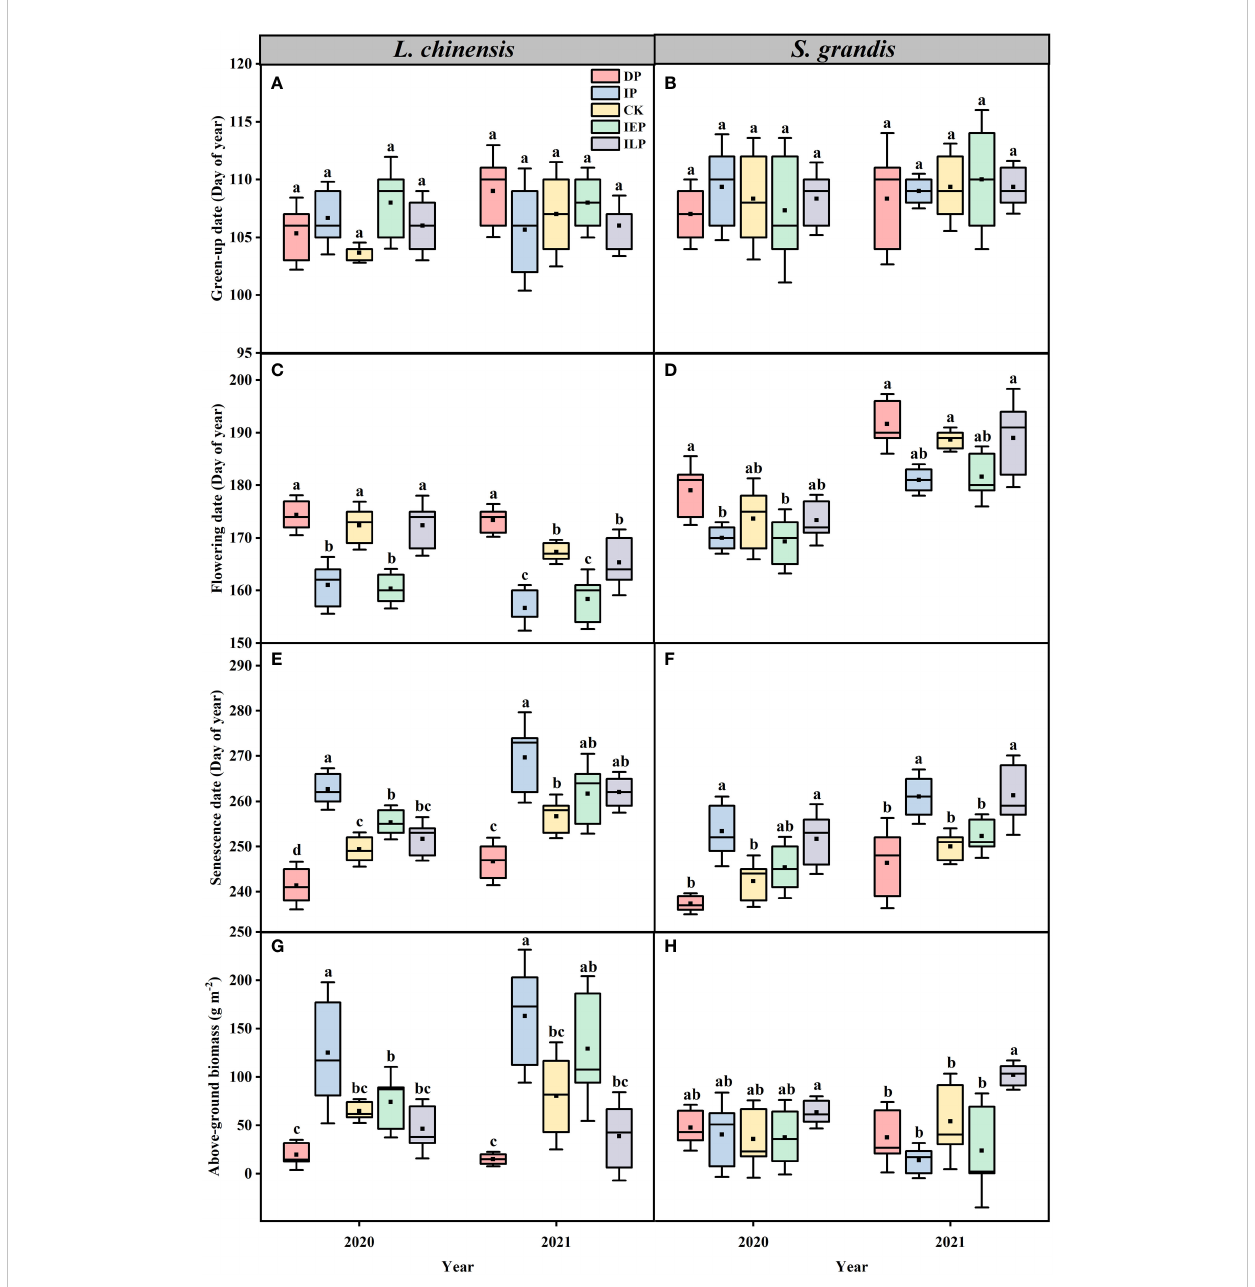
FIGURE 3 Effects of intra-annual precipitation patterns on the dominant species (A, B) green-up, (C, D) fl owering, (E, F) senescence, and (G, H) above-ground biomass from 2020 to 2021. The signi fi cance of each factor in different treatments was tested by one-way ANOVA. In Tukey ’ s HSD ’ s multi-range test, the different letters at the top of each box represent signi fi cant differences between the different treatments (P < 0.05). Different colors represent the intra-annual precipitation treatment (n = 15, 5 individuals × 3 replicates). The boxes indicate the 25-75% con fi dence interval of each target variable. The solid lines and black squares inside the box represent the median and mean, respectively. Abbreviations are as in Figure